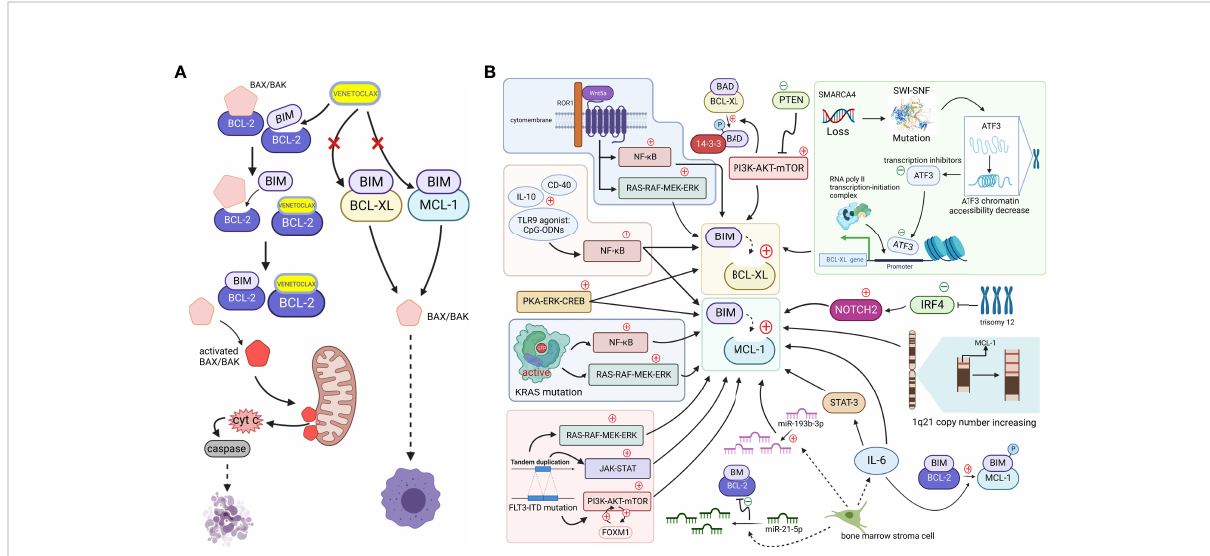
BH3-only protein mimetic, displaces the bound BIM from BCL-2. Free BIM activates the free proapoptotic protein BAX/BAK, and activated BAX/ BAK oligomerizes on the outer mitochondrial membrane, forming pore channels and releasing cytochrome c located between the inner and outer mitochondrial membranes into the cytoplasm. Cytochrome c activates caspases in the cytoplasm, stimulating the mitochondrial apoptotic pathway and mediating apoptosis. However, if MCL-1 and BCL-XL expression are upregulated (which may be caused by mechanisms shown in